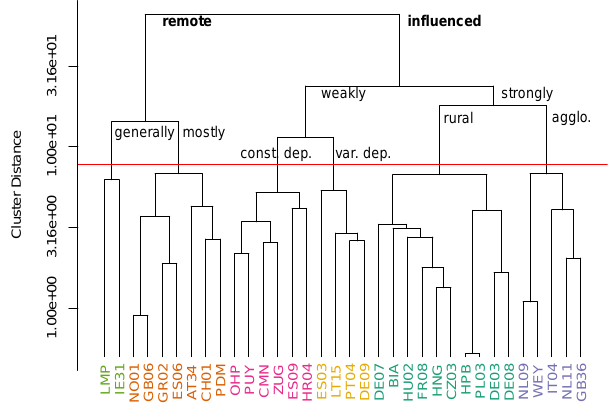
Fig. 3. Dendrogram of cluster analysis of parameters describing representativeness. Note that the y-axis (cluster distance or simply height) is logarithmic.